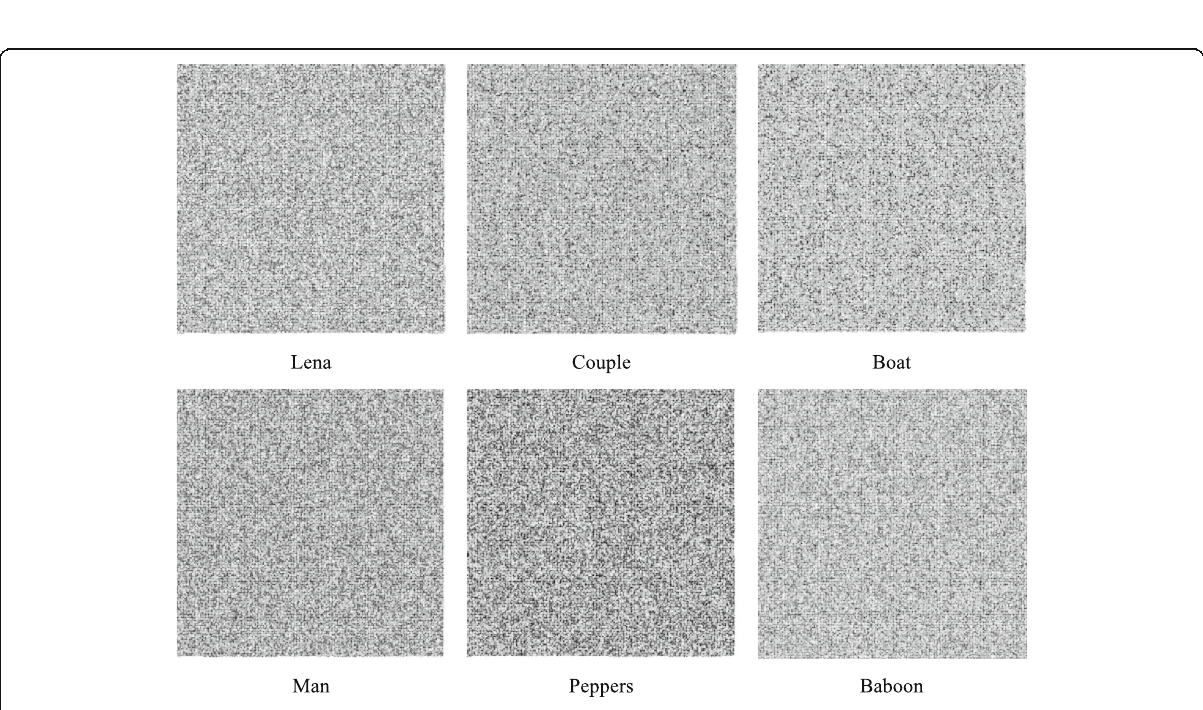
Fig. 8. Encryption results of Li et al. ’ s work